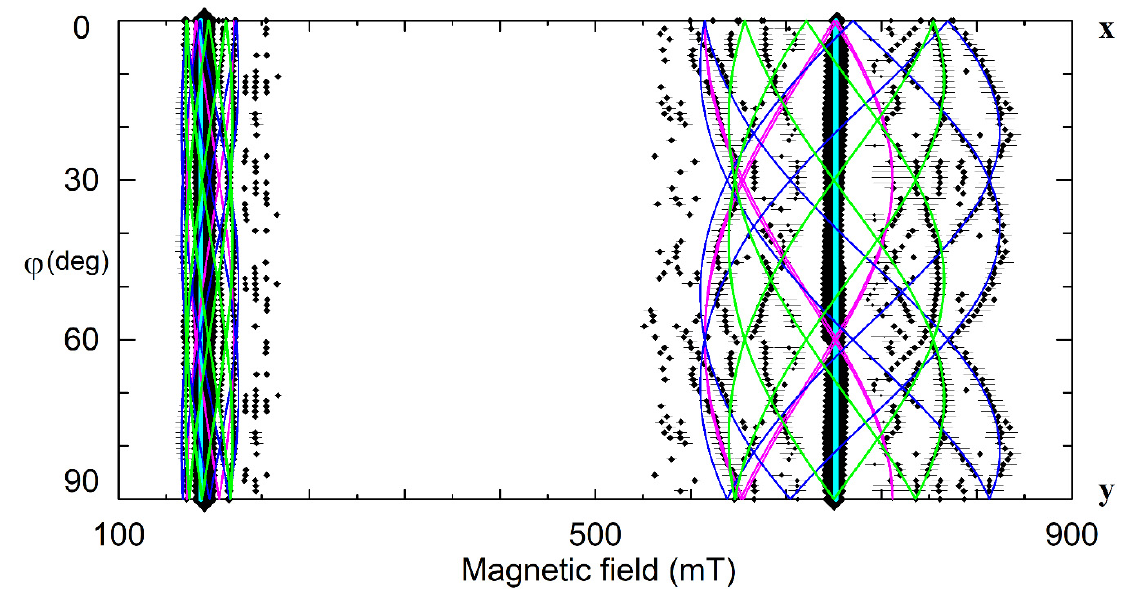
Figure 15. The angular dependencies of EPR spectra in the xy plane for LN:Cr 3+ grown from the melt with x m ≈ 60%, ν = 9.26 GHz. Rhombs represent line positions; their sizes are proportional to line intensities. Horizontal whiskers near